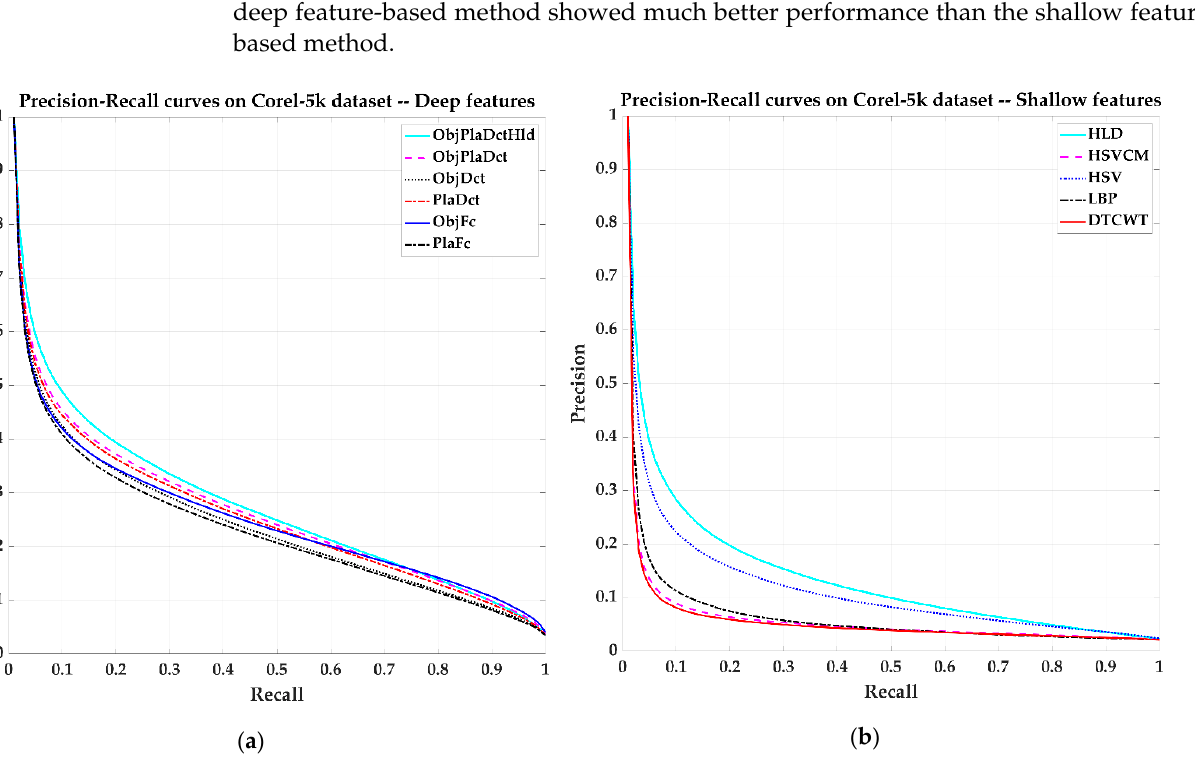
Figure 11. Comparison of different image retrieval methods on the Corel-5k dataset with Top NR = 12. The micro-structure map defined in the MSD method captures the direct relationship between an image’s shape and texture features. MTH integrates the co-occurrence matrix and histogram advantages and can capture the spatial correlation of color and texture orientation. HID can capture the internal correlations of different image feature spaces with image structure and multi-scale analysis. The correlated primary visual texton histo- gram features (CPV-THF) descriptor can capture the correlations among the texture, color, intensity, and local spatial structure information of an image.